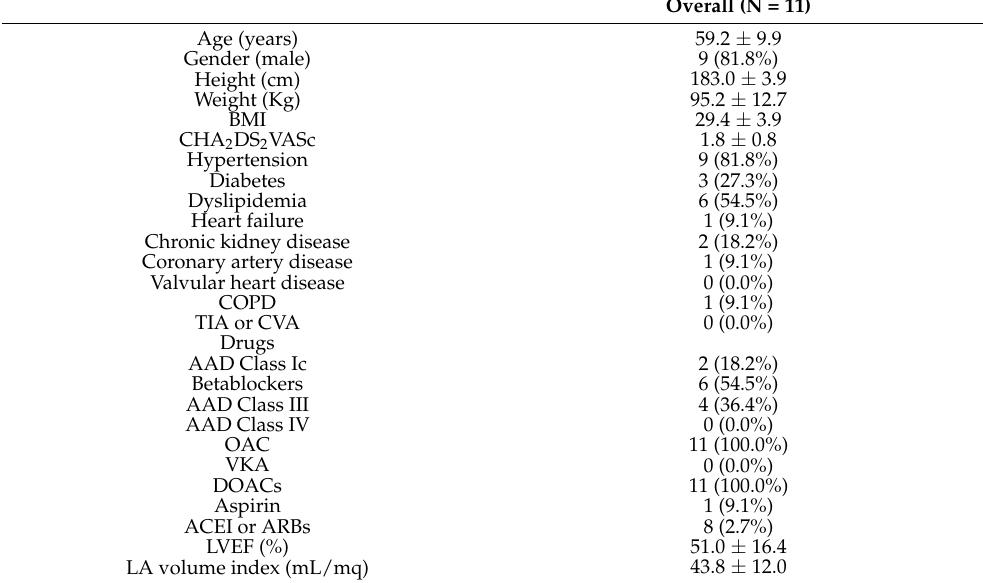
Table 1. Clinical characteristics of